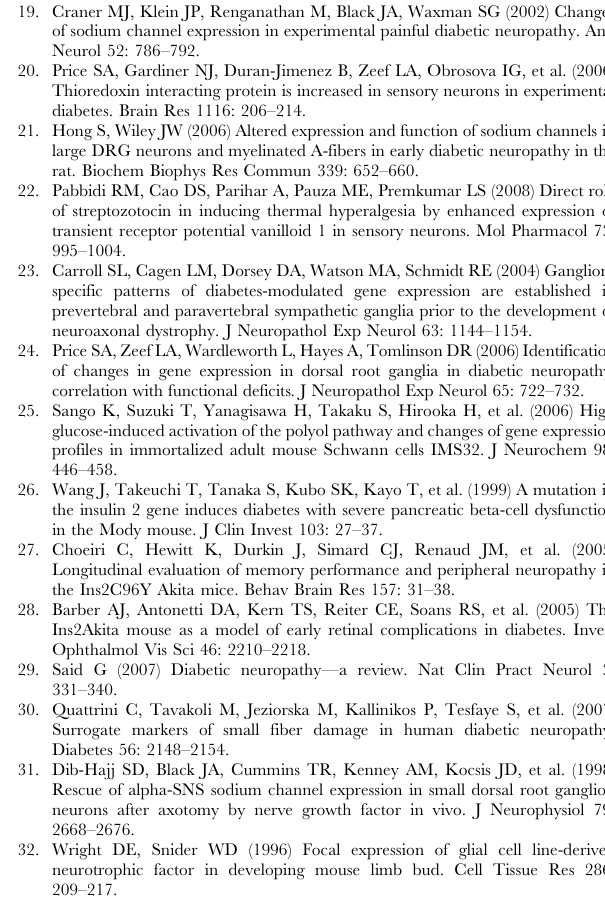
Table S1 List of primers used for qPCR confirmations. Table S2 Body weight and tail vein blood glucose measurements in Ins2 Akita/ + and control Ins2 + / + mice used for the microarray experiment. Results represent the mean 6 standard error of the mean (S.E.M.; Ins2 + / + : n= 5; Ins2 Akita/ + : n = 5). Found at: doi:10.1371/journal.pone.0010832.s006 (1.24 MB